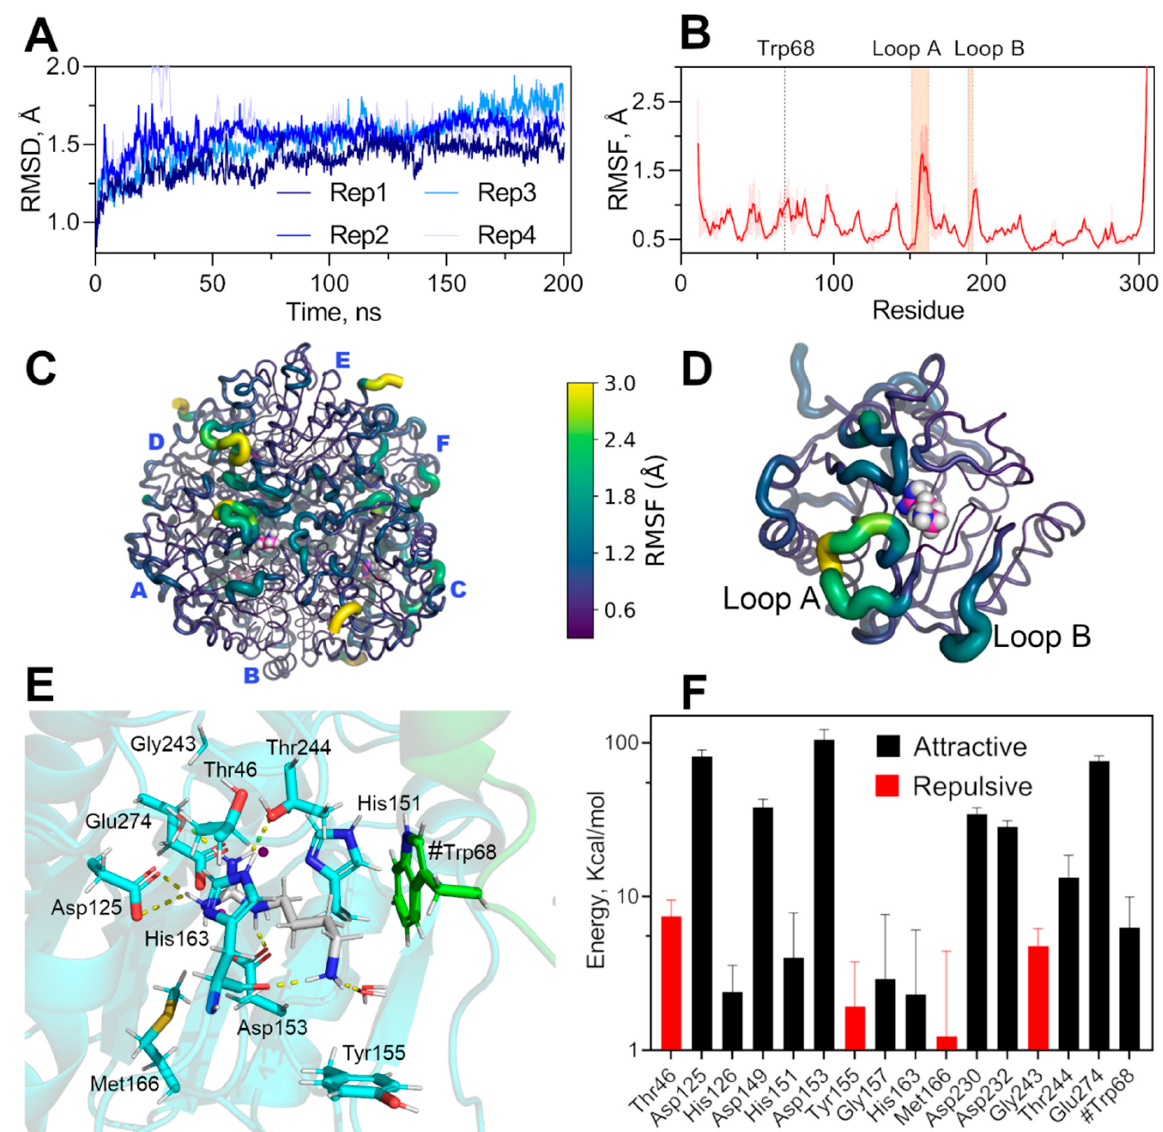
Figure 6. Molecular dynamic simulation of hexameric EcAGM and non-bonding interaction energy of agmatine binding- site. ( A ) RMSD of four replicates of 200 ns each. ( B ) RMSF for CA of EcAGM, mean and standard deviation calculated for six monomers and four replicates are shown. ( C , D ) RMSF mapped on hexameric and monomer structure, respectively. Structures are shown as cartoon putty according to the RMSF values scale (0.3–3 Å); the last five C-terminal residues are not shown. ( E ) Agmatine binging site after energy minimization, residues of the monomer analyzed are shown in cyan, agmatine is shown in white and green the neighboring monomer’s residues. Polar interactions are shown as yellow dashed lines and were calculated with Pymol 2.0. ( F ) Potential interaction energy calculated with MD simulations for residues at 5 Å of agmatine. Mean and standard deviation are shown. Only residues with a mean of over 1 kcal/mol are shown.